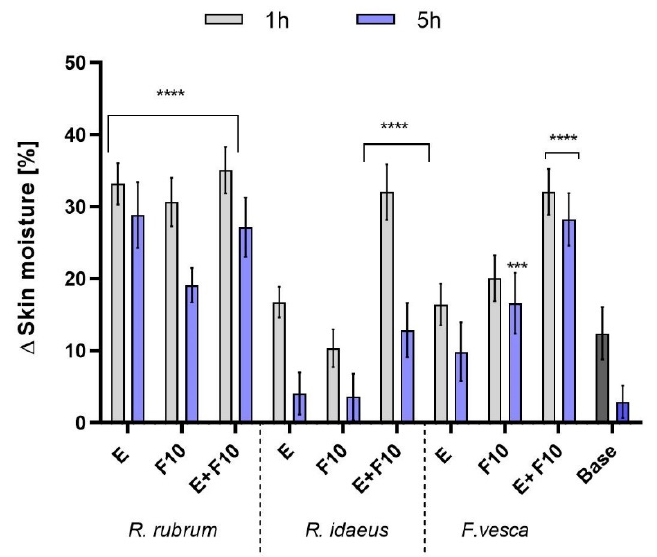
Figure 7. The influence of model skin tonics with R. rubrum, R. idaeus, and F. vesca extracts (E), ferments (F10), and extracts + ferments (E + F10) on skin hydration. Data are the mean ± SD of three independent measurements. **** p < 0.0001, *** p < 0.001 compared to the base tonic.